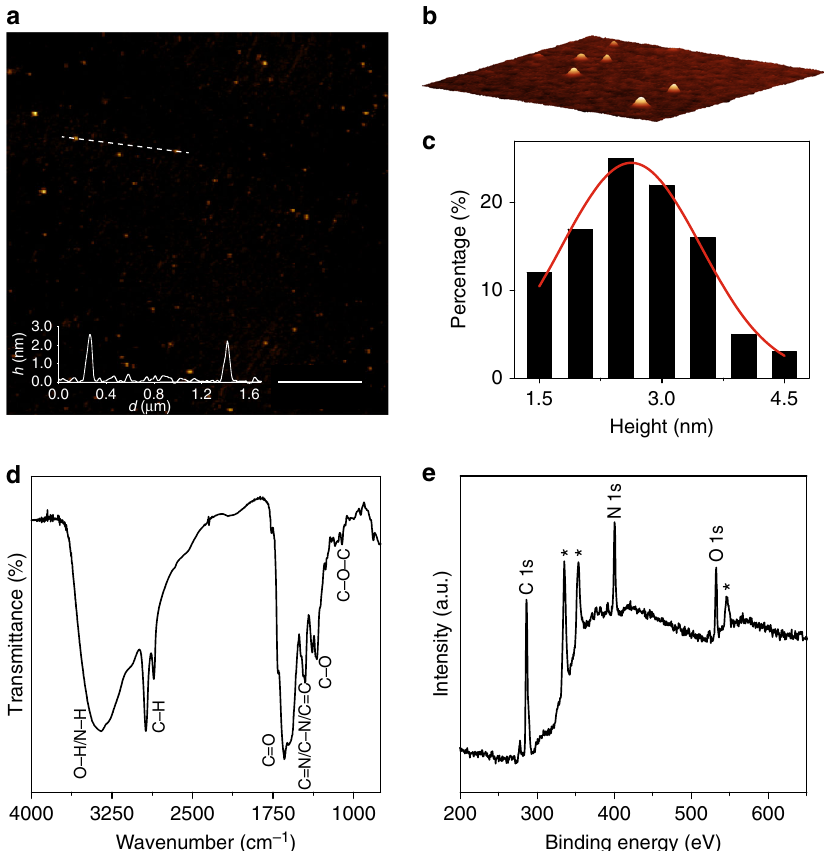
Fig. 2 Morphological and structural characterization of CNDs- R and CNDs- S . a Tapping mode AFM (4.4 × 4.4 μ m) from a drop-cast CNDs- R aqueous solution on a mica substrate (scale bar, 1 μ m), inset is the height pro fi le along the dashed line; b three-dimensional close-up AFM image (0.5 × 0.5 μ m) of CNDs- R ; c size histogram with curve fi t using a Gaussian model; d FT-IR spectrum of CNDs- S ; e XPS survey spectrum of CNDs- S showing the C1s, N1s, and O1s (deconvoluted spectra are in Supplementary Figure 4, *from Au substrate Au4d3, Au4d5, and